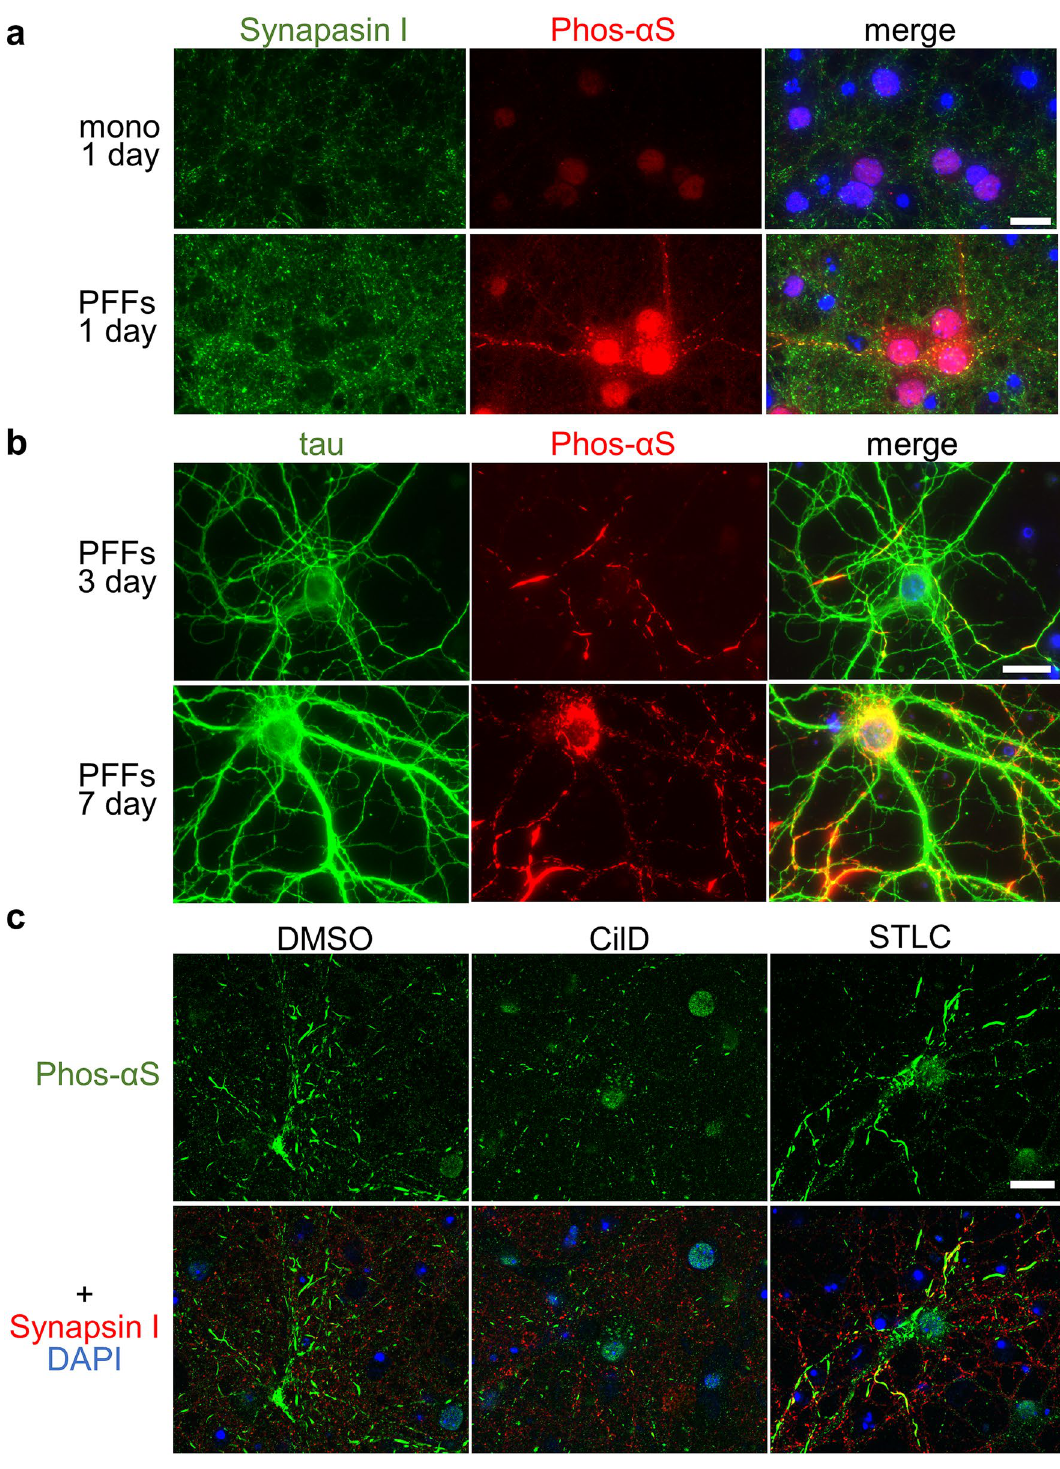
Figure 5. Seed-dependent phosphorylation of α-synuclein in pre-synaptic region of primary-cultured neurons. ( a ) Seed-dependent phosphorylation of α-synuclein (Phos-αS) in the pre-synaptic region. Primary-cultured cells grown in vitro for 14 days were treated with α-synuclein monomer (upper) or pre-formed fibrils (PFFs) (lower), and after one day, the cells were fixed and stained with anti-synapsin I (green) and anti-phosphorylated α-synuclein (red). Nuclei were stained with DAPI. Merged images are shown. ( b ) Seed-dependent phosphorylation of α-synuclein in axons. Primary-cultured cells grown in vitro for 14 days were treated with α-synuclein pre-formed fibrils (PFFs), and after 3 days (upper) or 7 days (lower), the cells were fixed and stained with anti-tau (green) and anti-phosphorylated α-synuclein (red). Nuclei were stained with DAPI. Merged images are shown. ( c ) Confocal laser microscopy analysis of cells treated with DMSO or drugs. Primary-cultured cells were treated with DMSO (left), CilD (center) or STLC (right) and stained with anti-phosphorylated α-synuclein (upper, green) and anti-synapsin I (lower, red). Nuclei were also stained with DAPI (lower, blue). Scale bars, 20